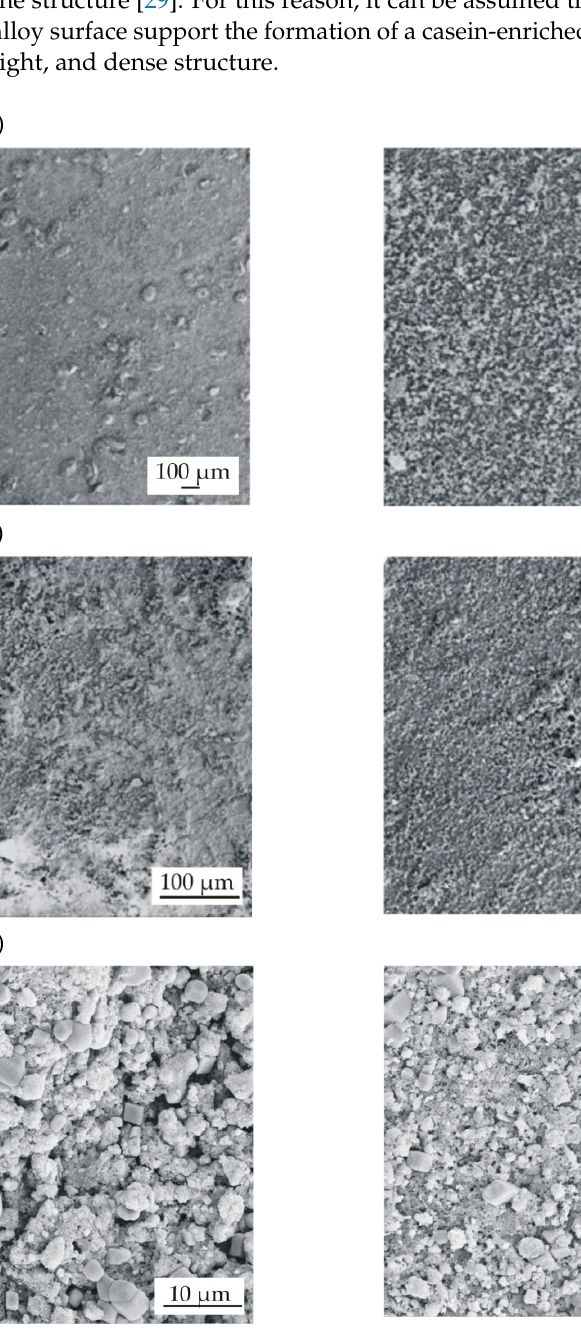
Figure 2. SEM images of surface morphology of conversion coatings deposited on MgCa2Zn1 alloy: ( a ) casein-free coating (NZ); ( c , e ) casein coating (CN) and MgCa2Zn1Gd3 alloy, respectively: ( b ) casein-free coating (NZ); ( d , f ) casein coating